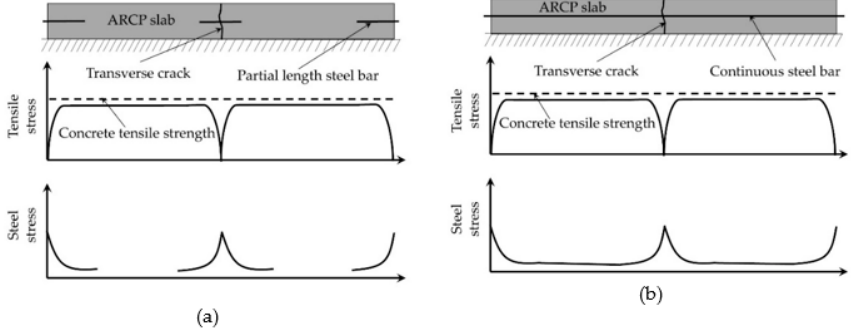
Figure 2. Cracking development in advanced reinforced concrete pavement (ARCP) with ( a ) partial length steel bars and ( b ) continuous steel bar.